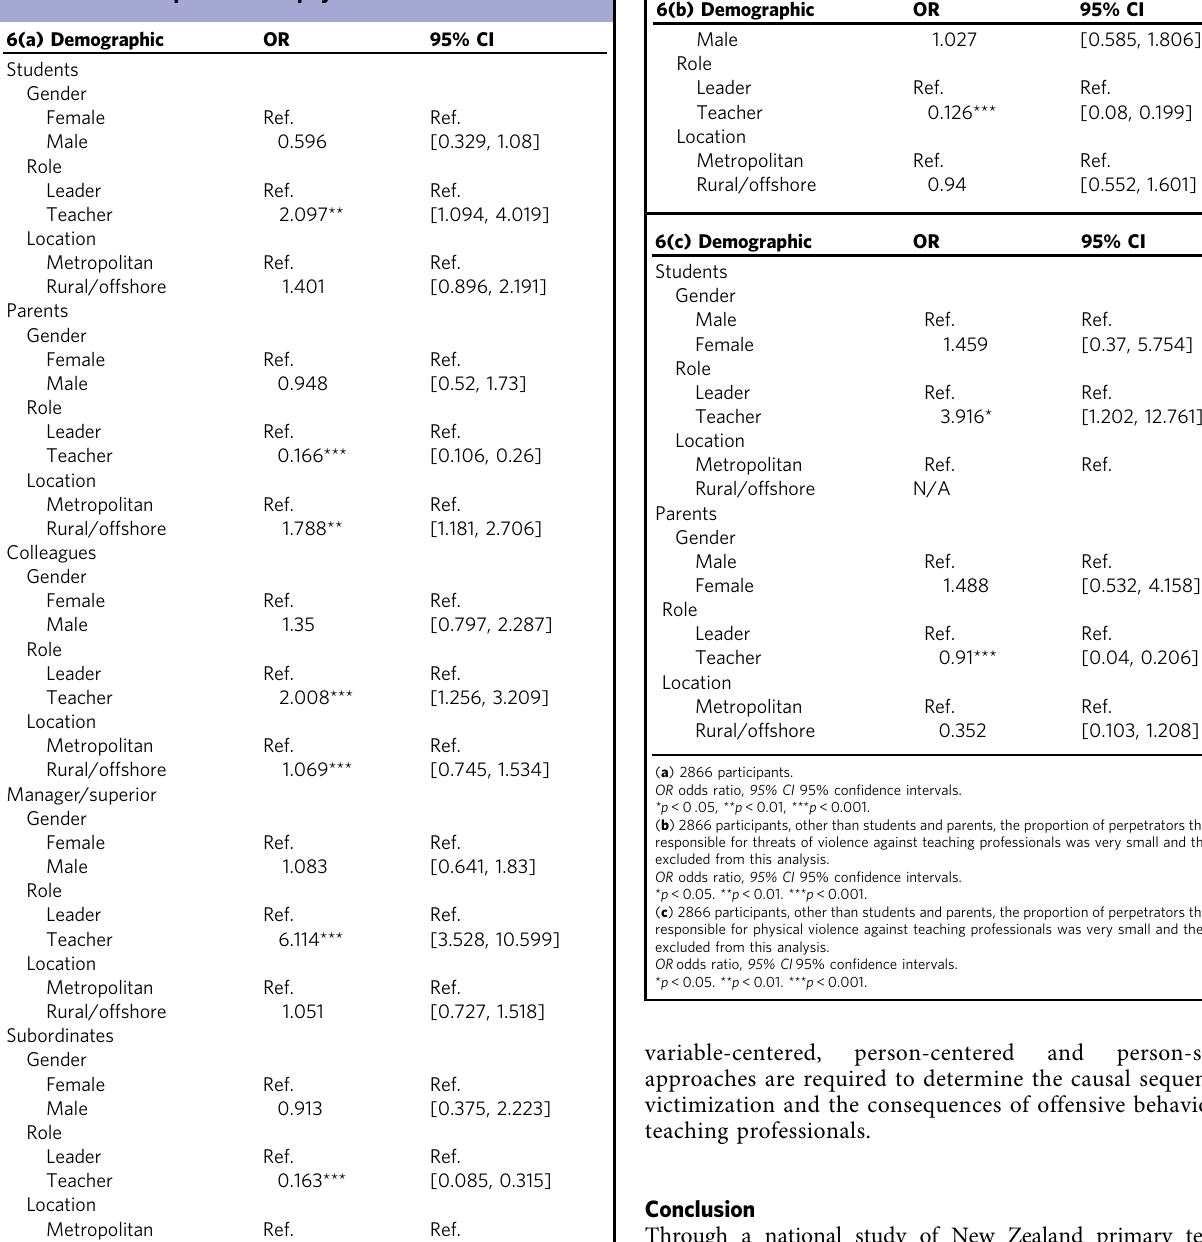
Table 6 a Perpetrators of bullying. b Perpetrators of threats of violence. c Perpetrators of physical